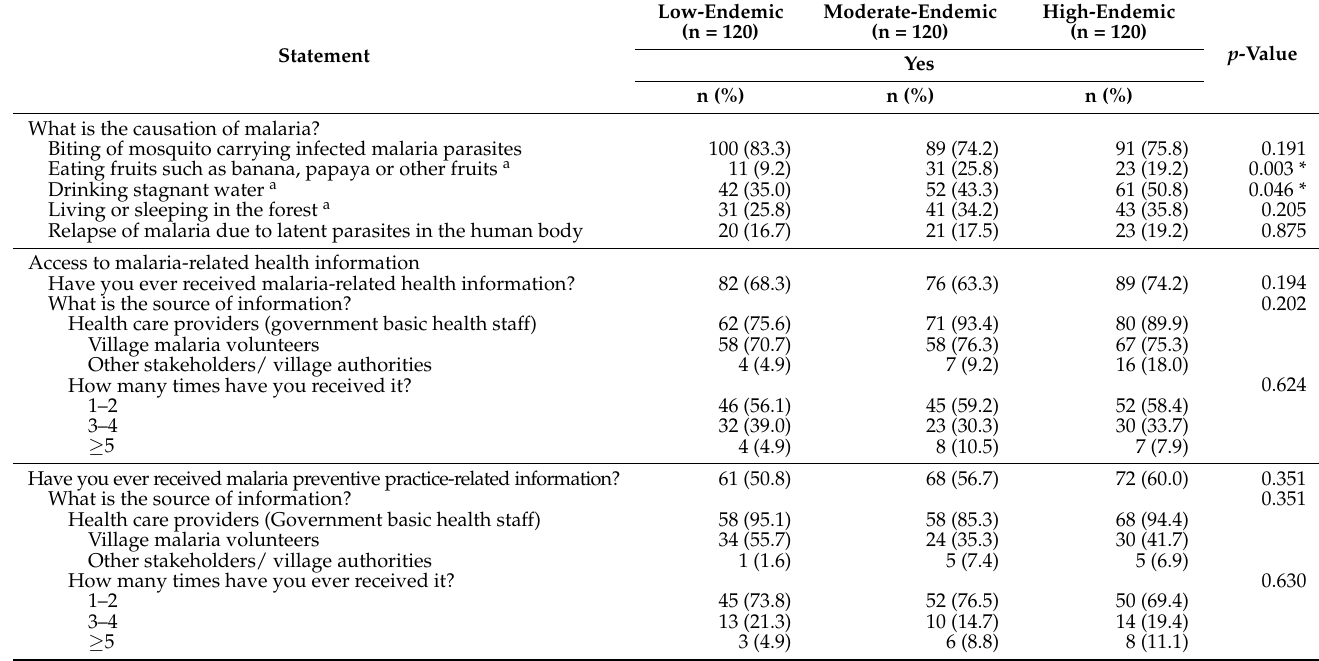
Table 2. Knowledge on causation of malaria and access to malaria-related health information.